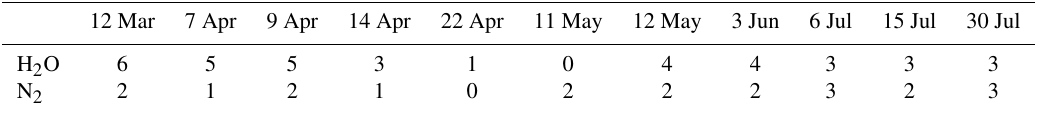
Table 1. Summary of lidar sessions during the campaign at Saint-Mandé in 2015. The numbers indicate the number of 5min measurements of both types: H 2 O refers to standard water vapor configuration and N 2 to measurements realized with a common nitrogen filter (see Sect. 4.2 for further information).